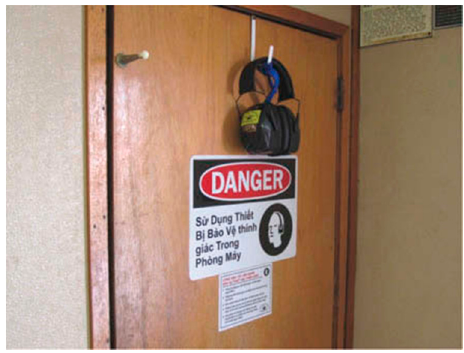
Figure 2. Signage and ear muffs on engine room door. Courtesy of Jeffrey L. Levin, M.D., University of Texas with approval by the Journal of Agromedicine [8].